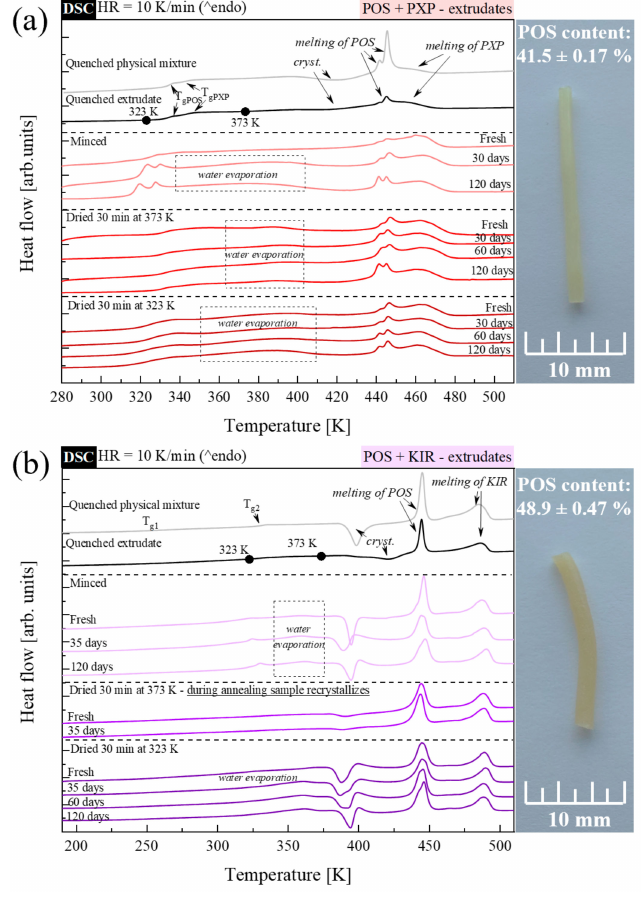
Figure 8. DSC thermograms of ( a ) POS + 50% PXP quenched physical mixture—gray line; quenched extrudate—black line; minced and non-dried extrudate (fresh, and stored for 30 and 120 days)— light red lines; minced and dried for 30 min at 373 K extrudates (fresh, and stored for 30, 60, and 120 days)—intermediate red lines; and minced and dried for 30 min at 323 K extrudates (fresh, and stored for 30, 60, and 120 days)—dark red lines. DSC thermograms of ( b ) POS + 50% KIR quenched physical mixture—gray line; quenched extrudate—black line; minced and non-dried extrudate (fresh, and stored for 5 and 120 days)—light purple lines; minced and dried for 30 min at 373 K extrudates (fresh, and stored for 35 days)—intermediate purple lines; and minced and dried for 30 min at 323 K extrudates (fresh, and stored for 35, 60, and 120 days)—dark purple lines. On the right-hand side, POS-based extrudates are